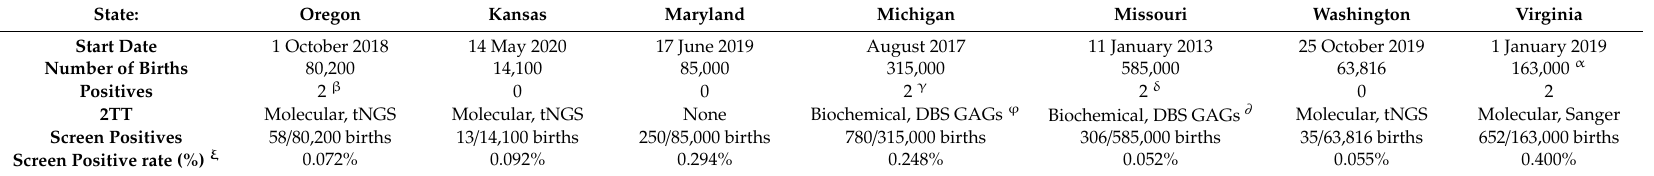
Table 1. Summary of MPS I NBS results from laboratories utilizing